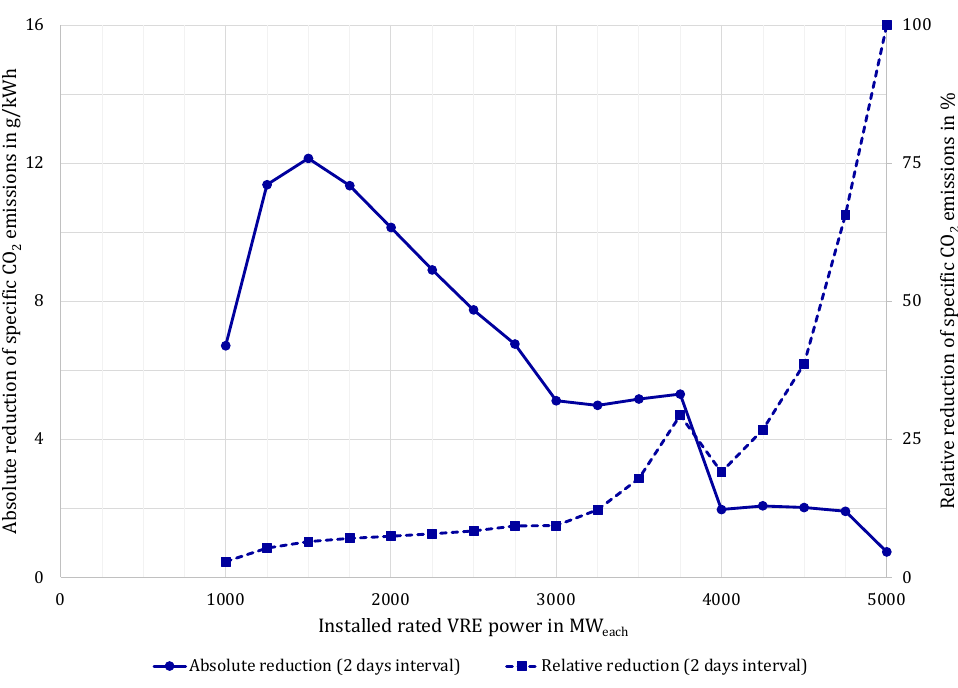
Figure 7. Absolute (circles) and relative (squares) reductions in CO 2 emissions as a result of UCO in comparison to UCH for scenario a (2 days interval).